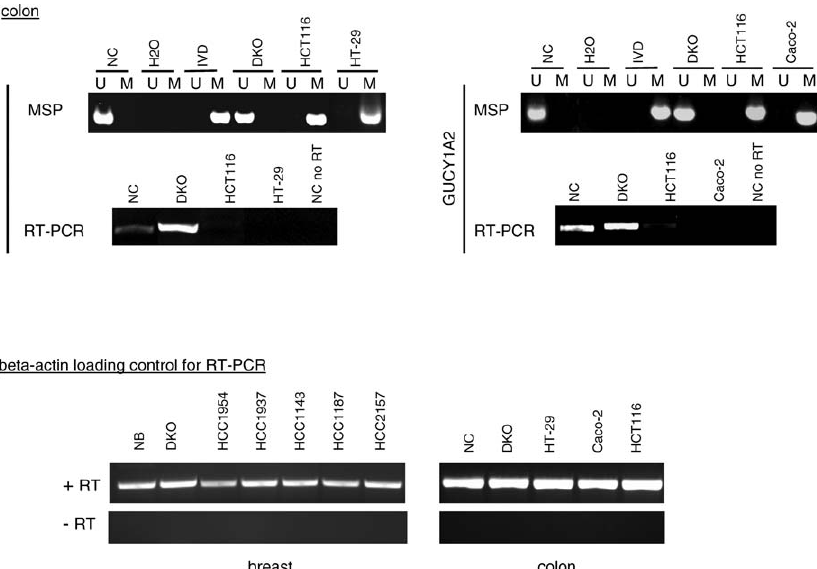
Figure 3. Common Gene Targets of Mutation and Hypermethylation in Colon Cancer MSP and RT-PCR expression analysis of selected genes. Each set of MSP and expression analyses are labeled with the corresponding gene name. U denotes the unmethylated band, and M denotes the methylated band. In vitro methylated DNA (IVD) was used as a positive control for methylation. cDNA from normal breast (NB) and normal colon (NC) was used to determine the expression of the genes in normal tissue. DKO corresponds to DNMT 1/3b double knockout HCT116 cells. All RT-PCR experiments were performed in parallel without reverse transcriptase as a control, and in all cases, no PCR product was generated (unpublished data). The control experiment performed without RT for normal colon is shown (NC no RT) for each gene. RT- PCR was performed for all cancer lines with beta-actin primers to control for the amount of cDNA.